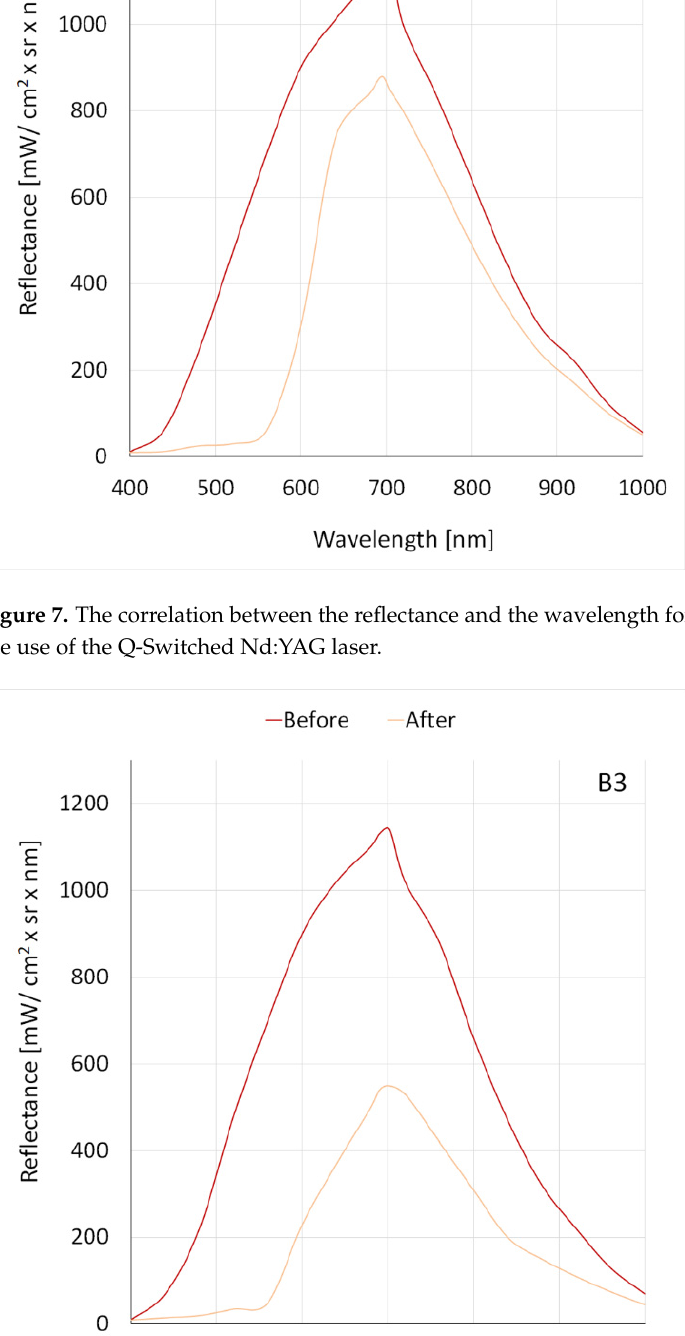
Figure 8. The correlation between the reflectance and the wavelength for the B3 dye before and after the use of the Q ‐ Switched Nd:YAG laser .